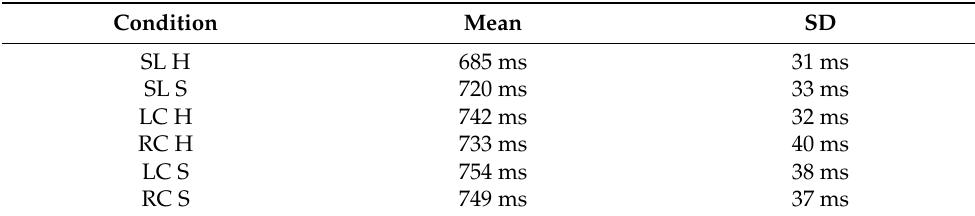
Table 1. Mean stride durations (mean) and standard deviations (SD) were indicated for each condition: straight line (SL), left circle (LC), and right circle (RC), for both ground conditions—hard (H) and soft (S)—and for the right forelimb and right hindlimb. For the left-circle condition, the equipped limb was the one outside the circle. For the right-circle condition, the equipped limb was the one inside the circle. Results are in